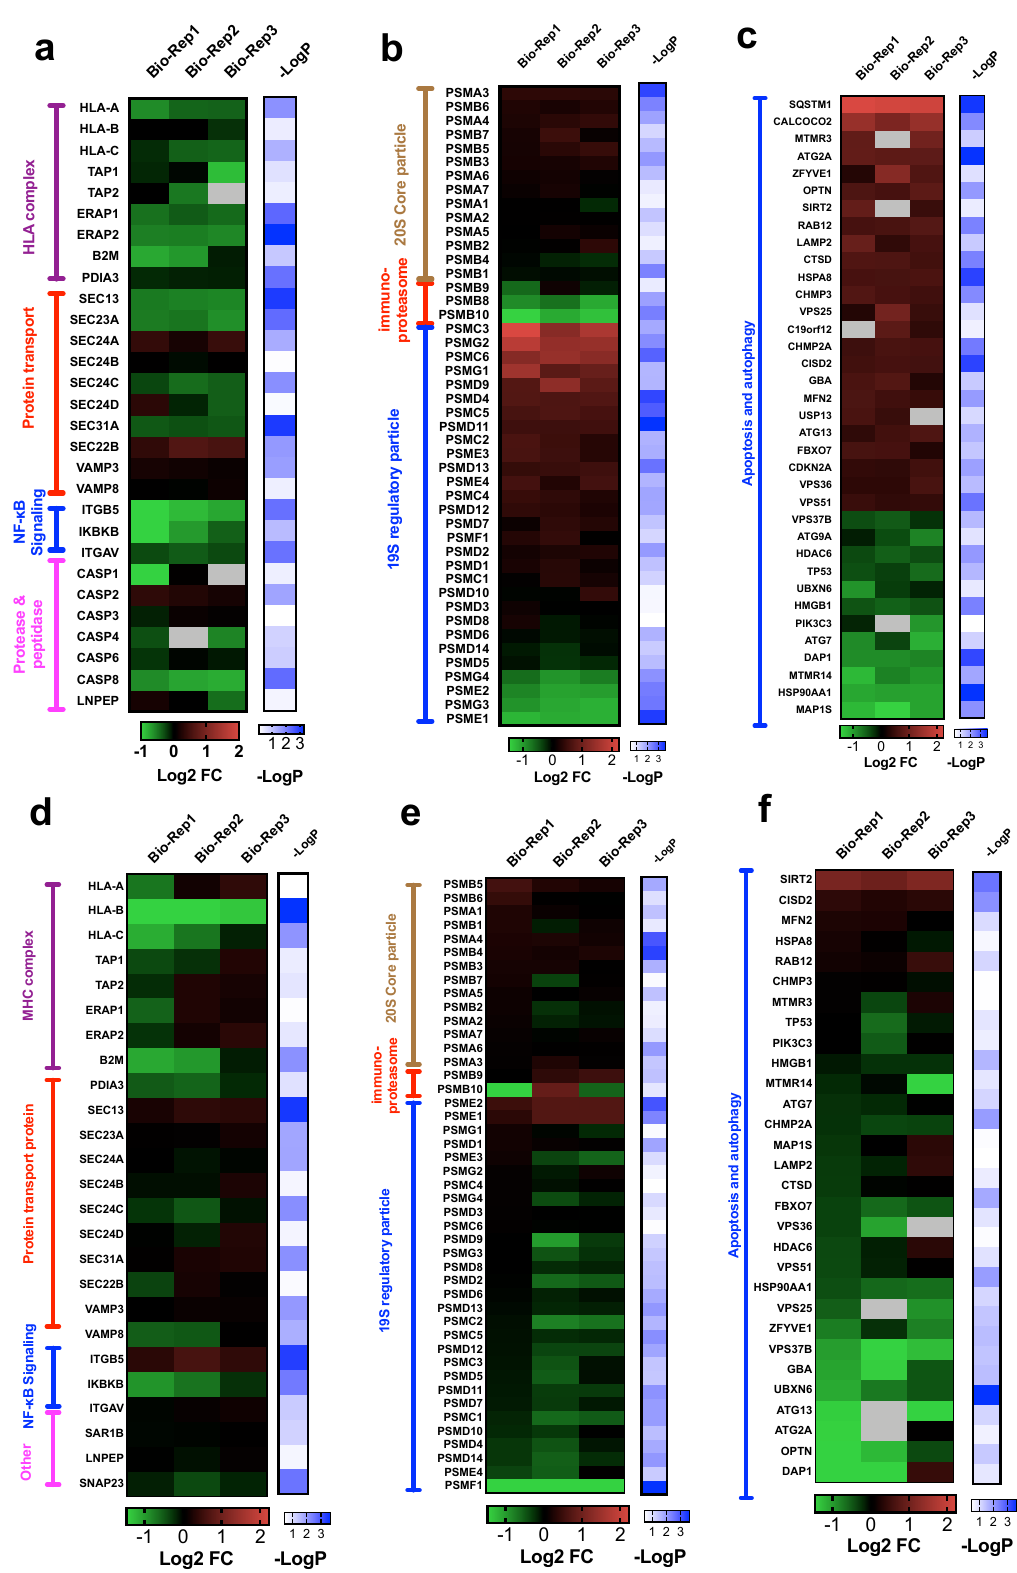
Figure 5. ( a – c ) Heatmaps of log2 ratio H/L (i.e., fold change) of proteins involved in antigen processing and presentation ( a ), proteasome assembly ( b ), autophagy and apoptosis cascade ( c ) in PC9-OsiR/PC9 cells. ( d – f ) Heatmaps of log2 ratio H/L (i.e., fold change) of proteins involved in antigen processing and presentation ( d ), proteasome assembly ( e ), autophagy and apoptosis cascade ( f ) in H1975-OsiR/H1975 cells. Note that − logP standards for the − log10 of one-sample t-test p